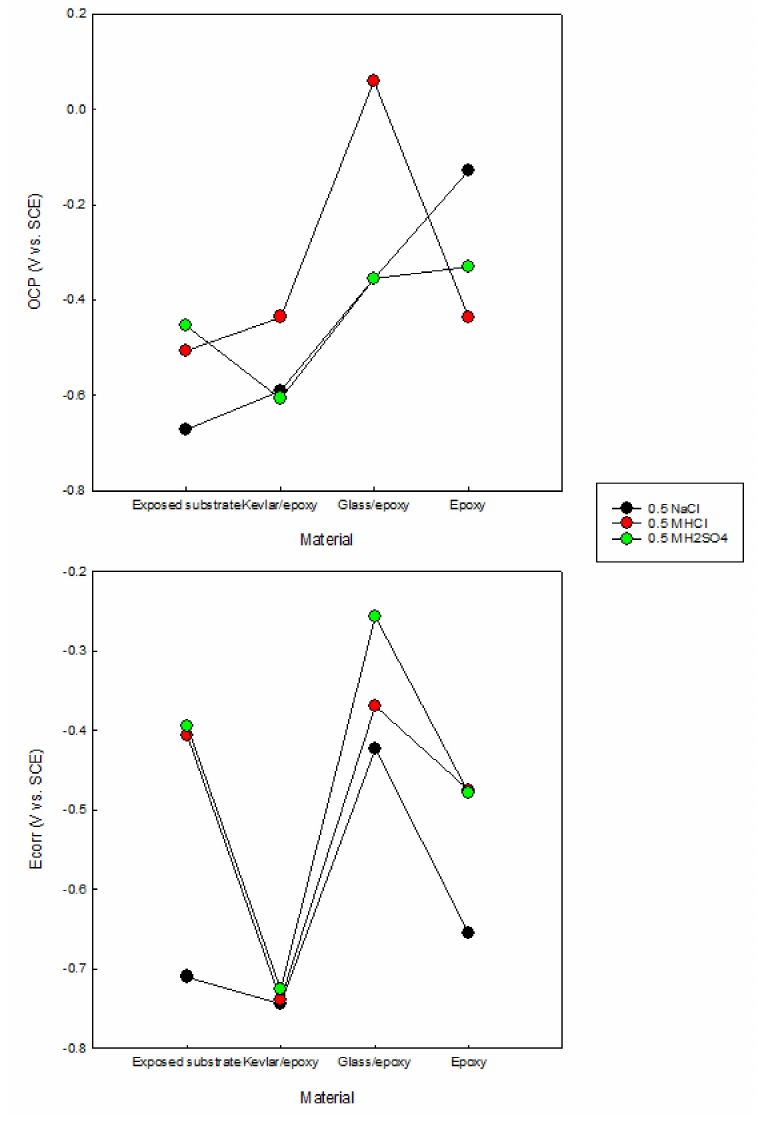
Figure 6. Open-circuit and corrosion potentials in 0.5 M NaCl, 0.5 M HCl, and 0.5 M H 2 SO 4 solutions for the exposed substrate and glass/epoxy, Kevlar/epoxy, and epoxy